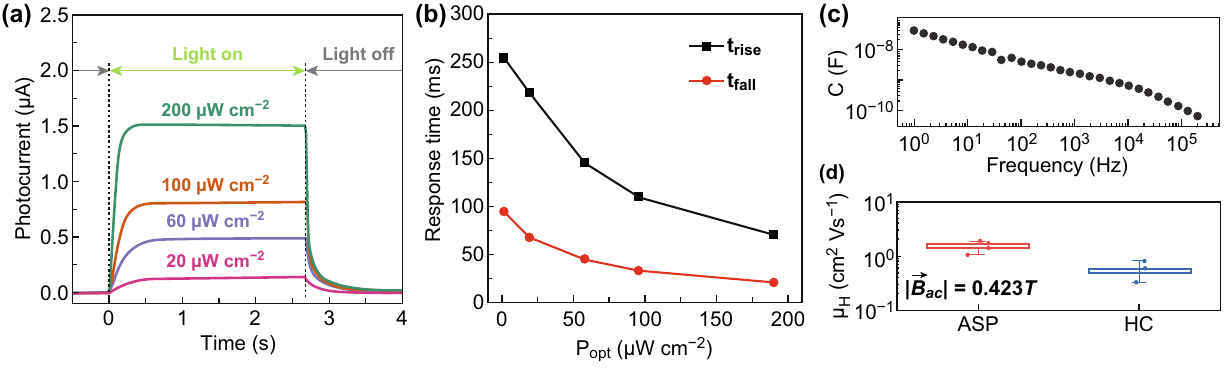
Fig. 5 Characterization and insight into the transient response of Ag 2 BiI 5 photodetectors. a Photodetector response to pulsed light ( λ = 505 nm) of variable power. b Extracted rise and fall times. c Photodetector capacitance as a function of frequency for an applied bias of 0 V. d Hall mobility of Ag 2 BiI 5 thin